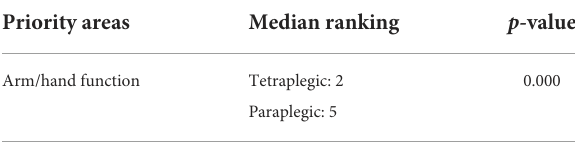
TABLE 2 Summary of statistical findings in tetraplegic, paraplegic, and caregivers.